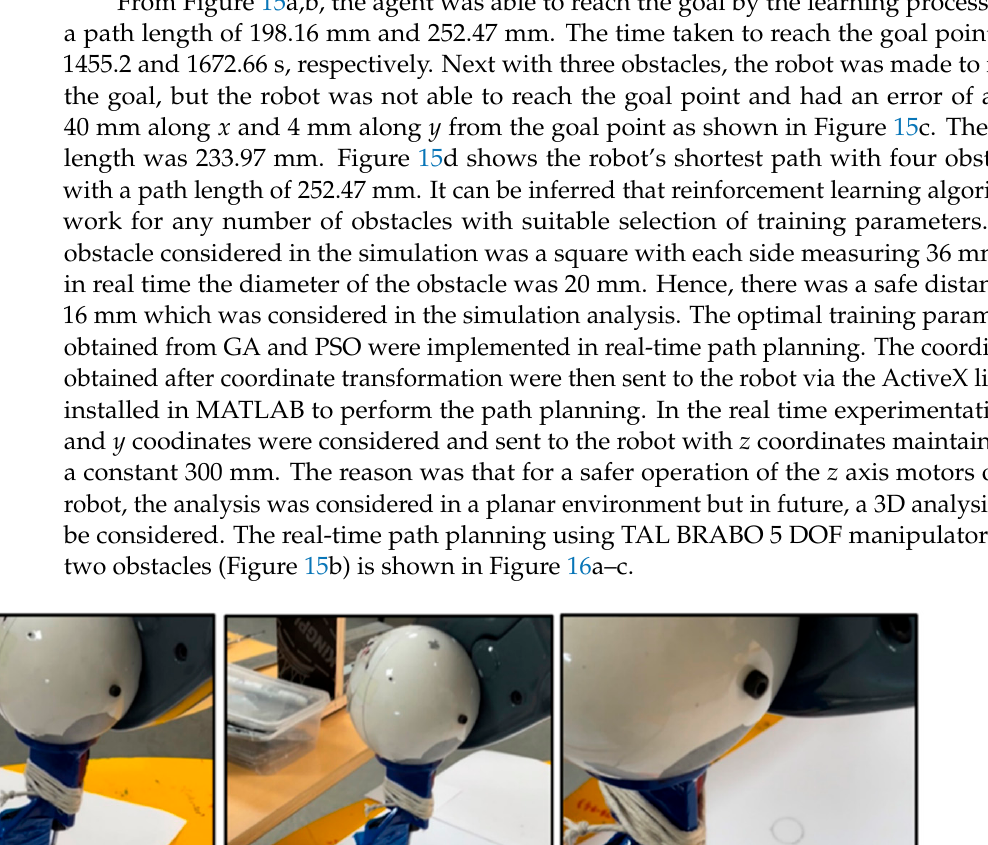
Figure 17. ( a ) Real-time Path Speed Profile of the Robot with Two Obstacles using Double DQN ( b ) Real-time Joint Velocities of the Robot with Two Obstacles using Double DQN. The above figure shows the linear speed profile and angular velocity generated for the TAL BRABO robot with two obstacles using Double DQN. The velocity was generated for the path illustrated in Figure 17b to show that the variation of the joint velocities was very minimal while performing path planning. Thereby it shows that the use of Double DQN online-based path planning was smooth. 6. Conclusions This work mainly focused on vision-based path planning in a robotic manipulator using different reinforcement learning algorithms such as Q-Learning, SARSA, DQN, and Double DQN and found out the optimal training parameters using GA and PSO. This work could be used in industries where humans and robots work together such as welding, assembly operations, spray painting, and so on. In this work, an industrial